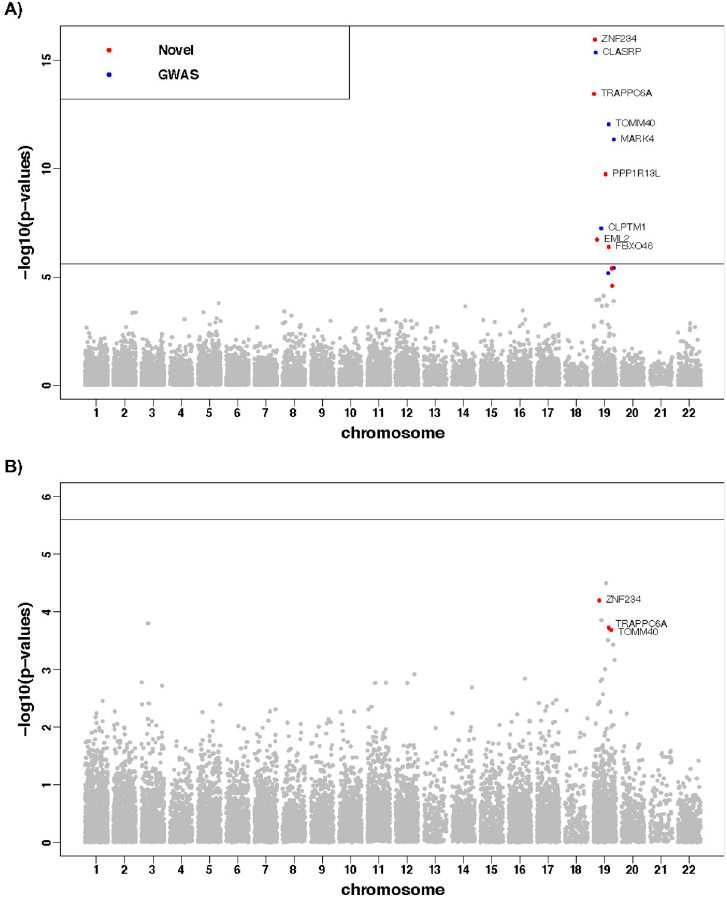
Fig 2. Manhattan plots of meta VC-TWAS for AD clinical diagnosis (A) and VC-TWAS of global AD pathology (B) with filtered DPR weights. Genes with FDR < 0.05 are colored in (A), with red for novel risk genes and blue for known AD risk genes. Genes with FDR < 0.05 in meta VC-TWAS of AD clinical diagnosis and p-value < 0.0013 in VC-TWAS of global AD pathology are colored in red in